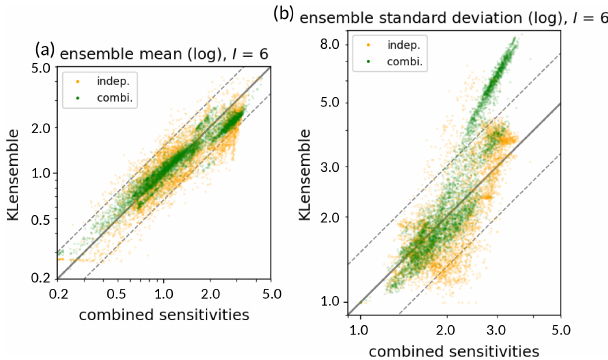
Figure 10. Scatterplot of ensemble statistics for isoprene emis- sion perturbations. Shown are logarithmic ensemble mean (a) and standard deviations (b) of the KL ensemble perturbations at each grid box as function of combined sensitivities. Ensemble statis- tics are shown for 32 combined (green) and 7 independent (or- ange) sensitivities, which both refer to the same set of I = 6 con- sidered arguments. The solid gray line indicates the identity line (e.g., µ KL = 1 . · µ sens for the ensemble mean) to the set of 32 com- bined sensitivities; the dashed gray lines represent an overestima- tion or underestimation by a factor of 1.5 (e.g., µ KL = 1 . 5 · µ sens and µ KL = ( 1 . 5 ) − 1 · µ sens